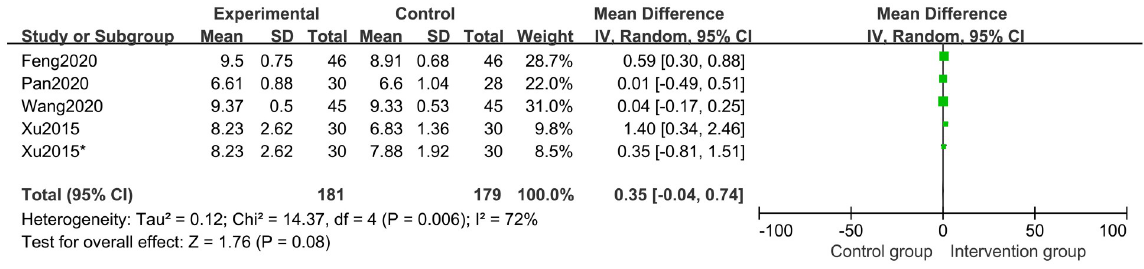
Fig 5. Forest plot of bone